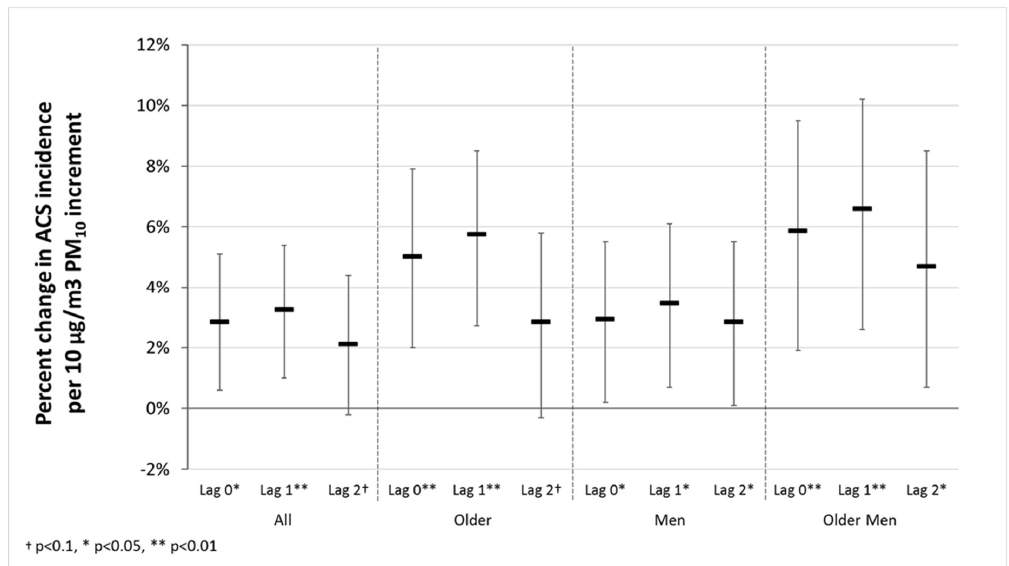
Figure 2. Immediate and delayed percent change (95% confidence interval) in ACS incidence for a 10 μg/m 3 PM 10 increase for men, women, as well as younger and older than 65 years. In Figure 2, a